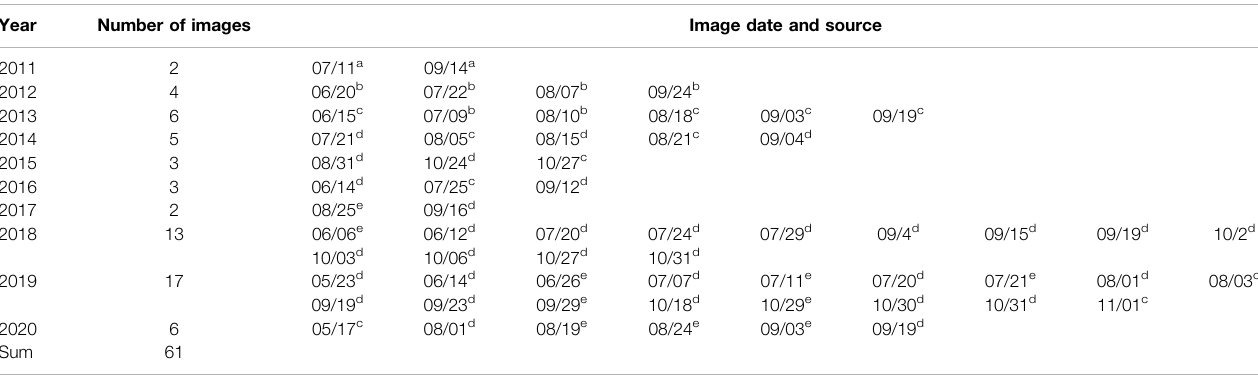
TABLE 2 | Satellite images dates and sources